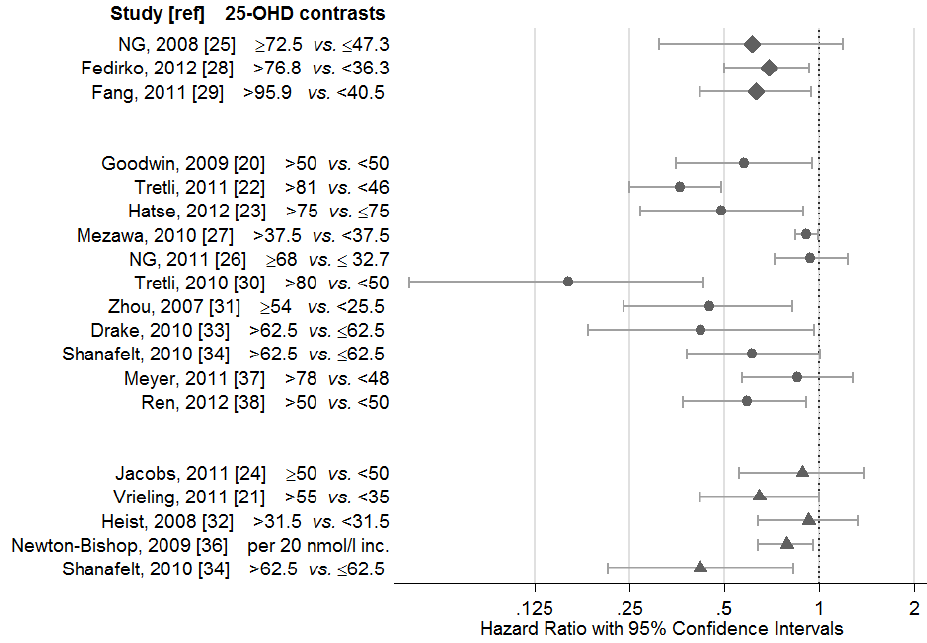
Figure 1. Hazard ratios with 95% confidence intervals from the reviewed studies, grouped by time of serum sampling, with regard to the time of diagnosis and start of treatment (25-OHD levels are given in